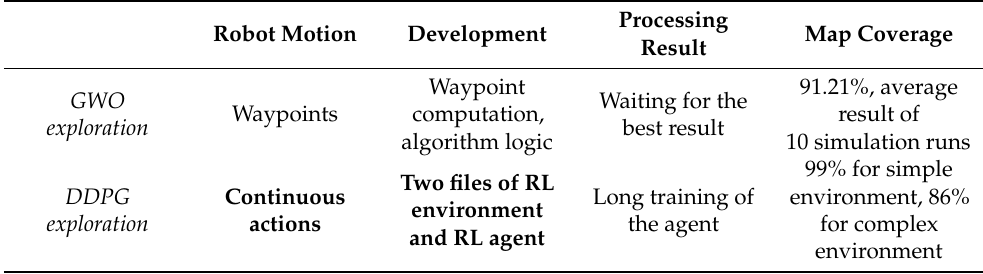
Table 5. Comparison analysis of the GWO exploration and the DDPG agent exploration. The advantages are highlighted in